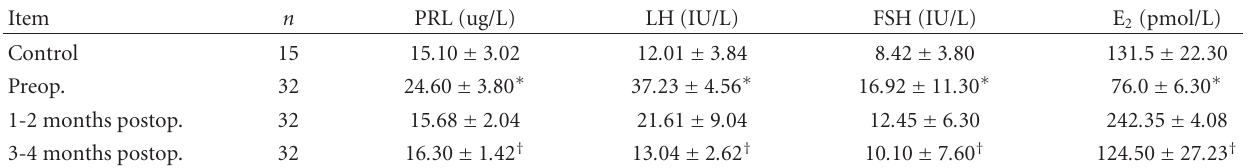
Table 2: Serum pituitary-gonadal hormone levels before and after transplantation in the 32 female ESRD patients and 15 female controls. Item